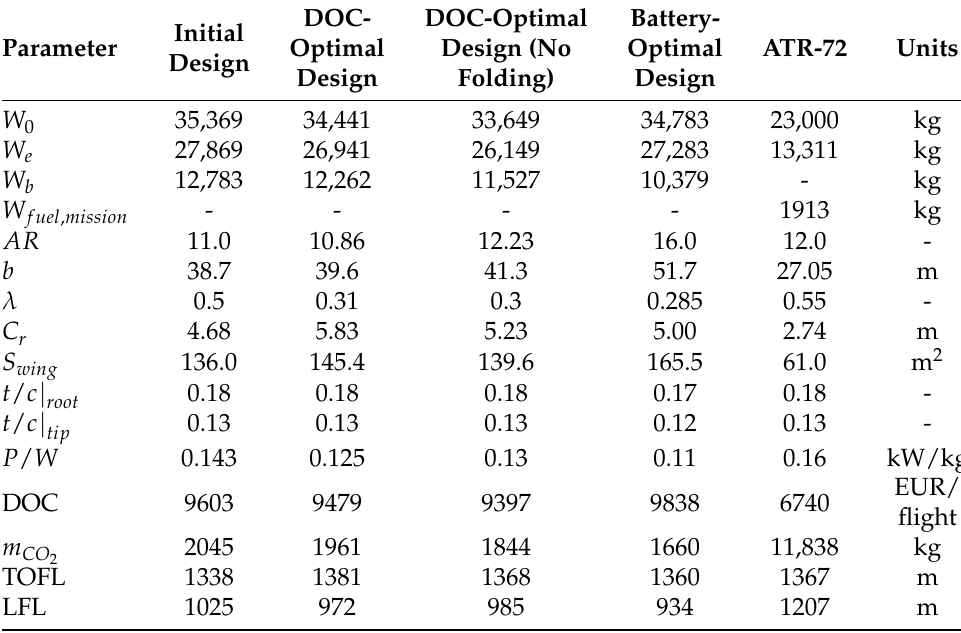
Figure 13. Wing planforms for selected optimization problems. Table 6. Comparison between optimized